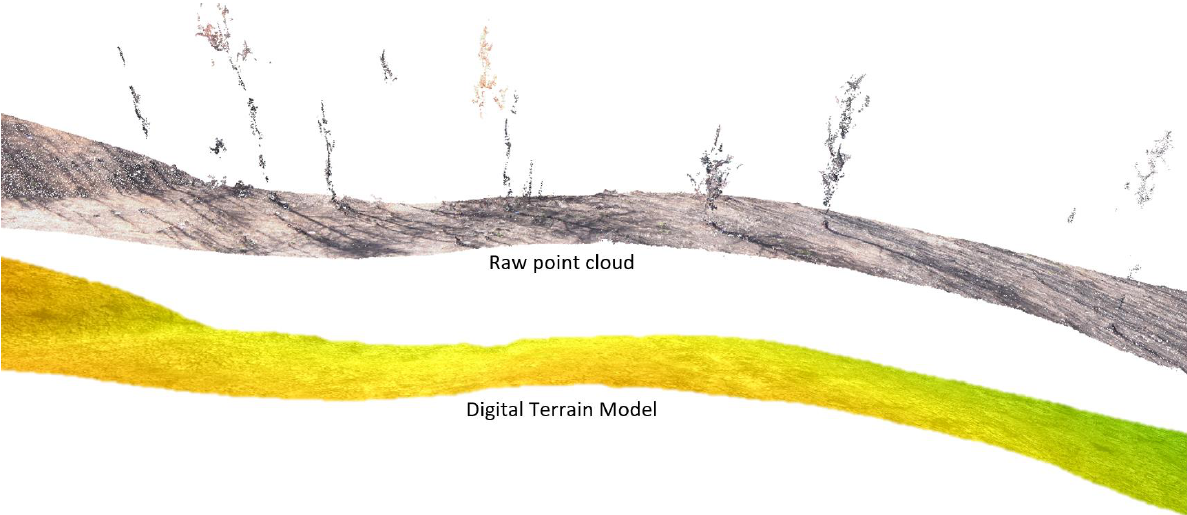
Figure 4. Transect (10m width) showing the raw point cloud (top) and the interpolated Digital Terrain Model (DTM,